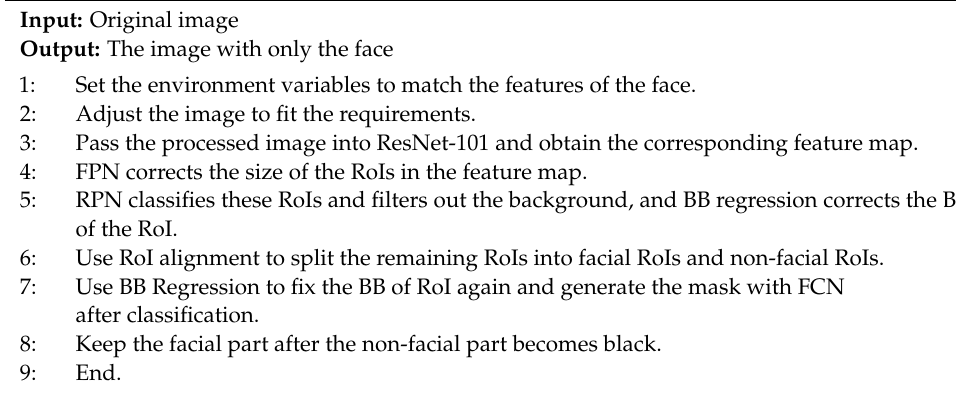
Algorithm 1 Face detection procedures